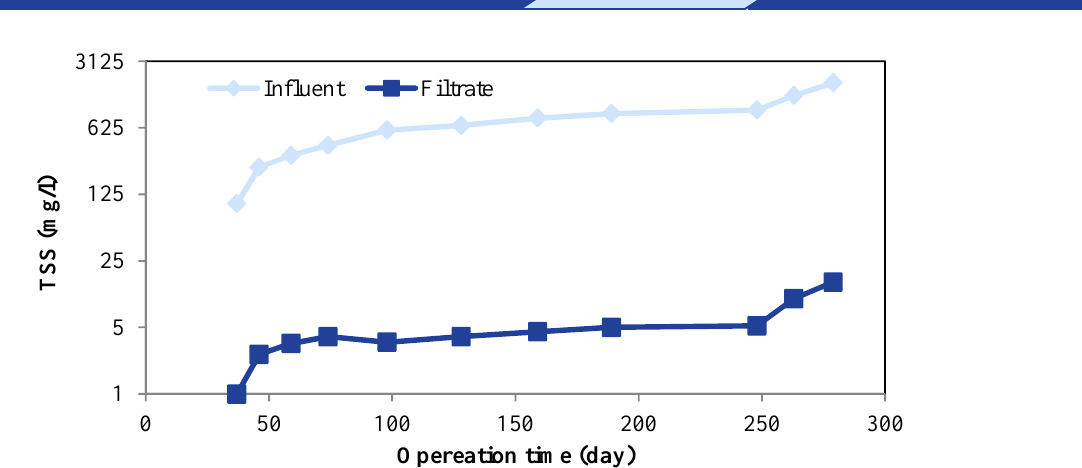
Figure 4. Changes in concentrations of total suspended solids (TSS) in different run times TSS: Total suspended